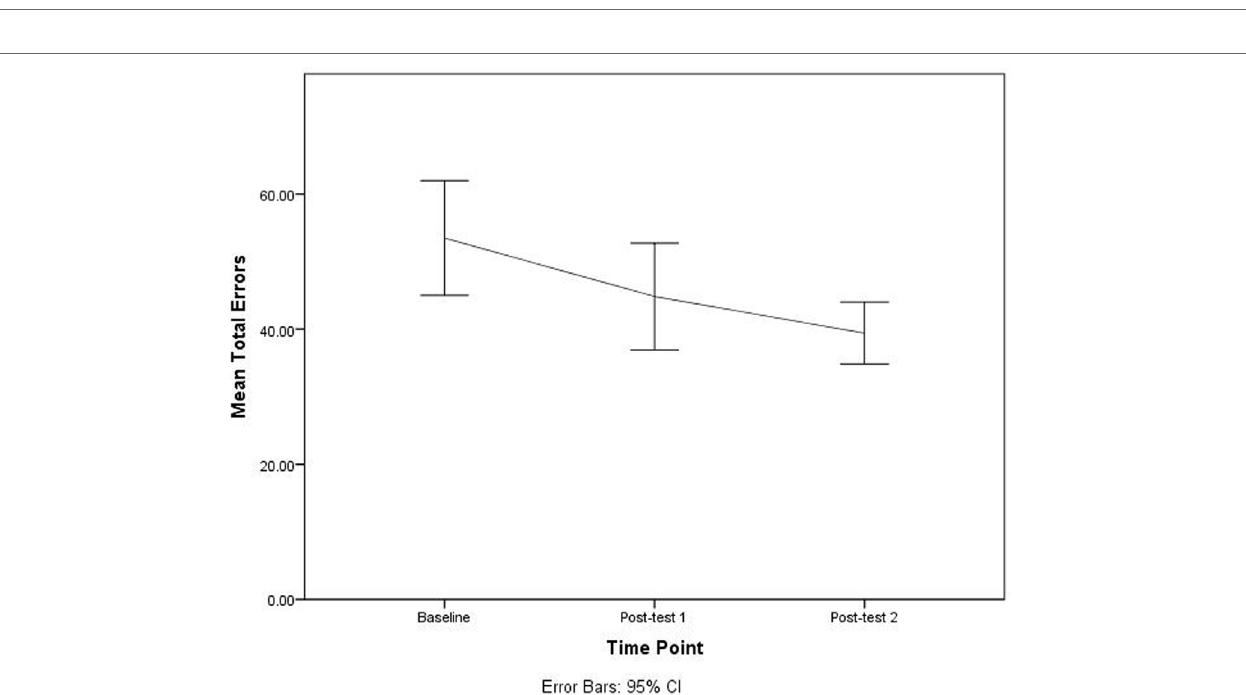
FigUre 3 | Number of adjustment to stimuli errors among baseline, post-test 1, and post-test 2.